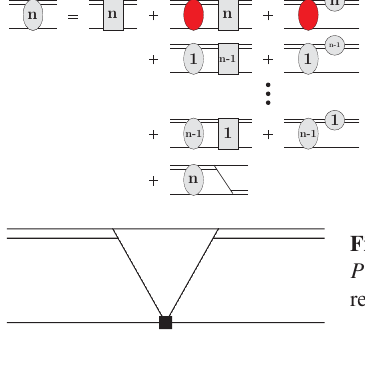
Figure 3. Top left is the EFT /π results up to N 2 LO and data [8] for the cross-section at a neutron lab energy of = 3 . 0 MeV. The band E n on N 2 LO result represents the estimated error of about 6%. On the other three figures the solid red line represents our preliminary N 3 LO results for A y at E n = 1 . 2 and 1 . 9 MeV with data from [9] and at E n = 3 . 0 MeV with data from [10] . On the bottom right figure the dashed green line comes from potential model calculations